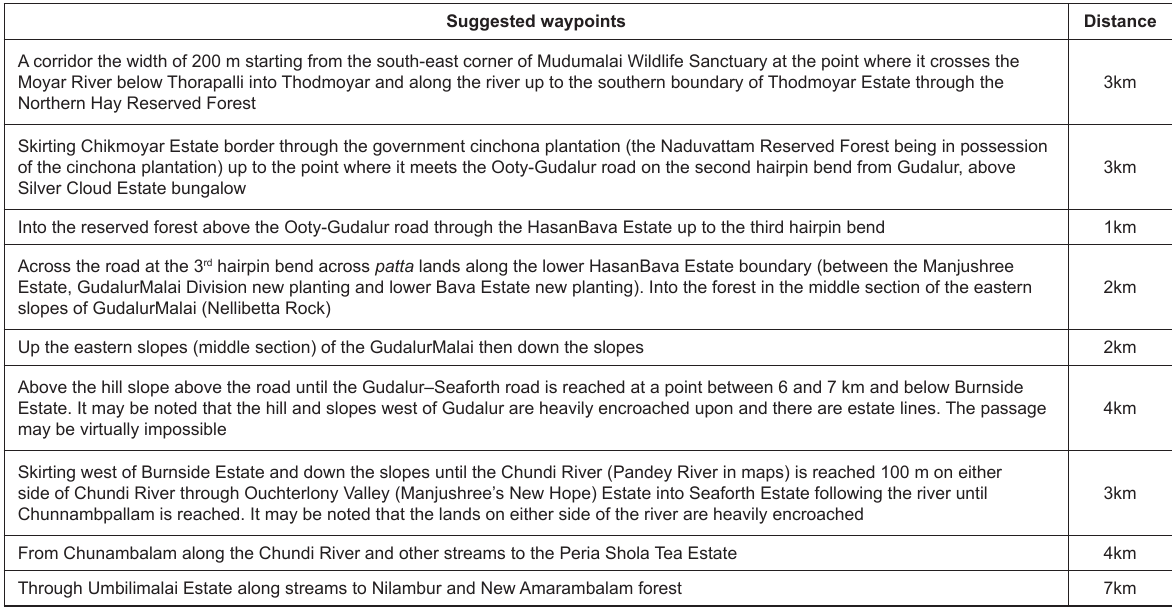
Table 2. The proposed Mudumalai-Ouchterlony Valley Nilambur-New Amarambalam corridor. Suggested waypoints